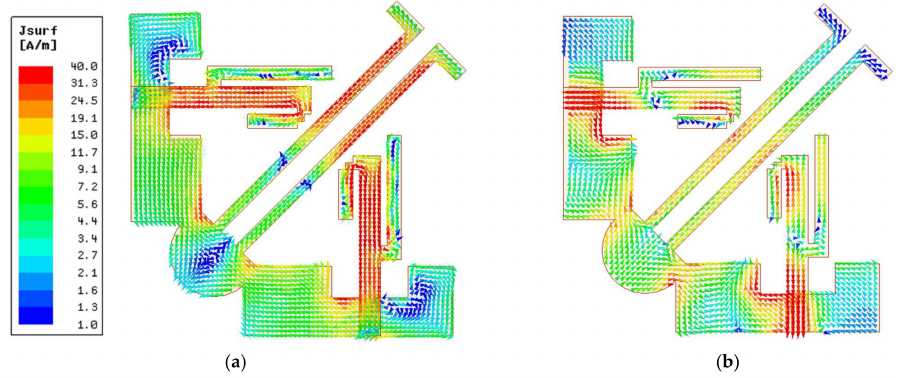
Figure 5. Simulated surface current directions. ( a ) 2.45 GHz, ( b ) 5.5 GHz.